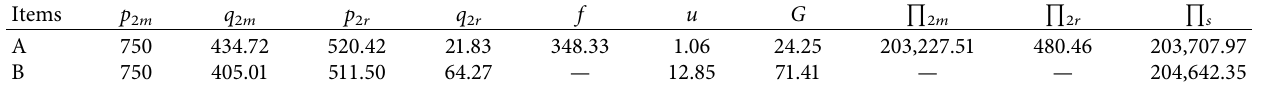
Table 2: The results in scenario 2 without a constraint on carbon emission regulations.